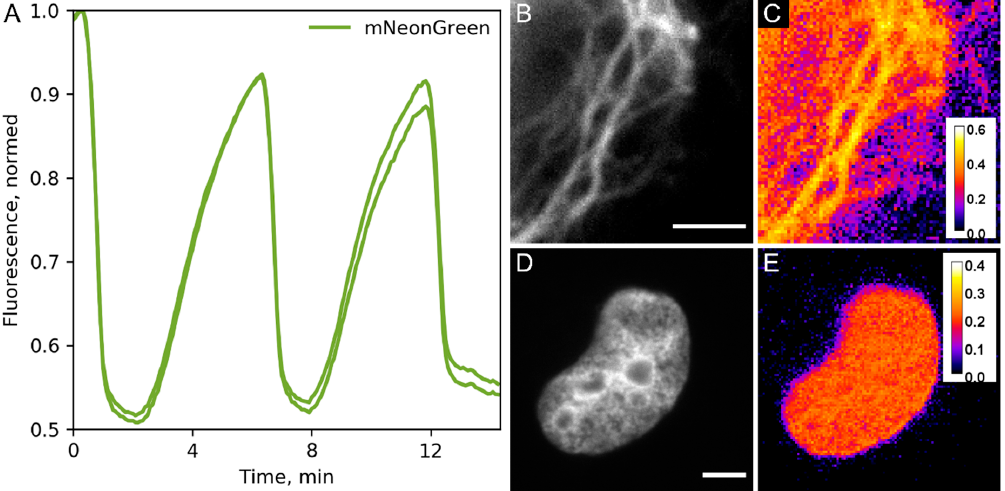
Figure 2. Possible applications of the reported FRET pair. ( A ) Repeating FRET activation in live HeLa cells. Green lines represent average intensities of mNeonGreen (donor) fluorescence in labeled nuclei of live HeLa cells transiently transfected with H2B-mNeonGreen-DiB1 construct (each line